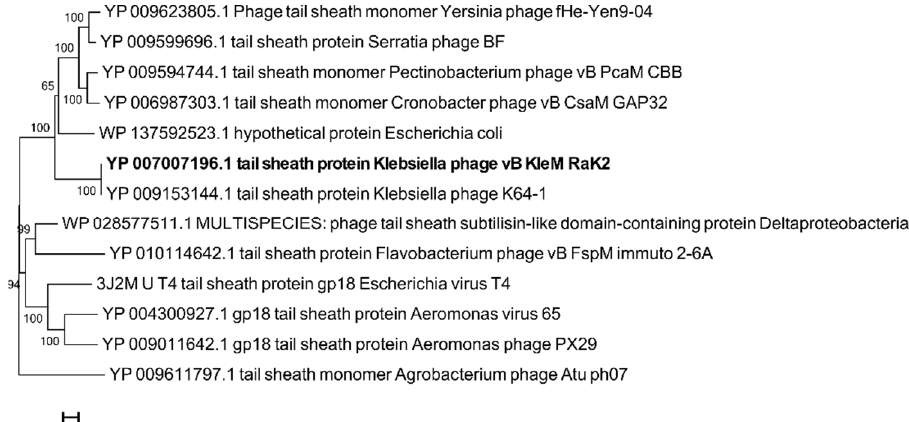
Figure 1. Phylogenetic analysis of protein 041 ( bold ) with selected structural proteins. The evolutionary history was inferred using the neighbor-joining method [31]. The percentage of replicate trees in which the associated taxa clustered together in the bootstrap test (2000 replicates) is shown next to the branches [32]. The evolutionary distances were computed using the number of differences method [33] and are in the units of the number of amino acid differences per sequence. Evolutionary analyses were conducted in MEGA7 [34].